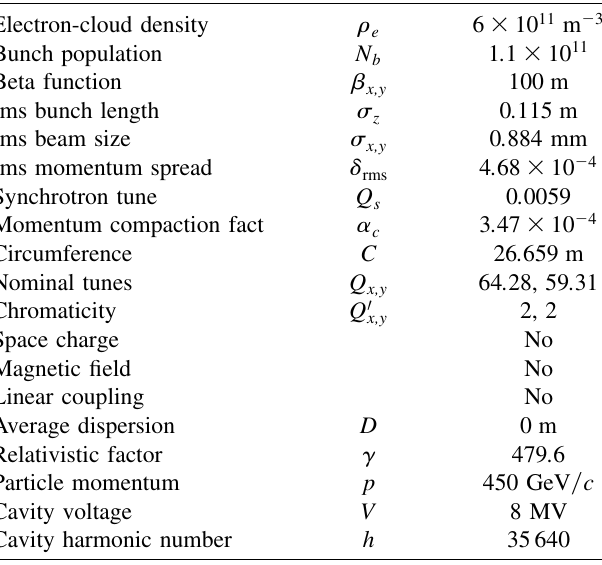
TABLE I. Parameters used for LHC at injection.